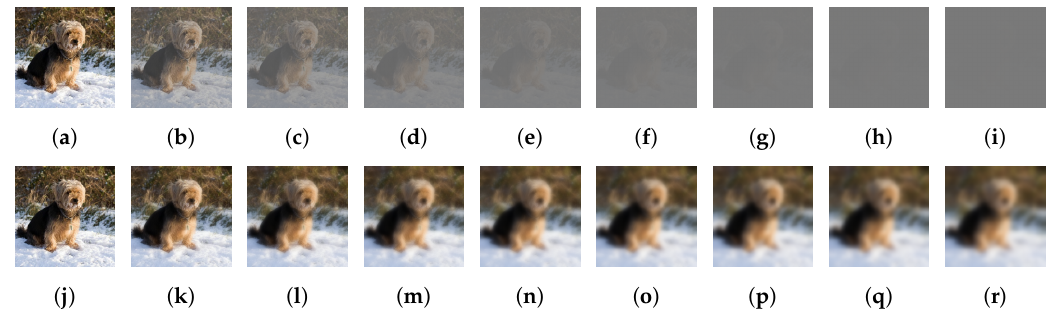
Figure 3. The gradient impact comparison between variance and variance pooling during